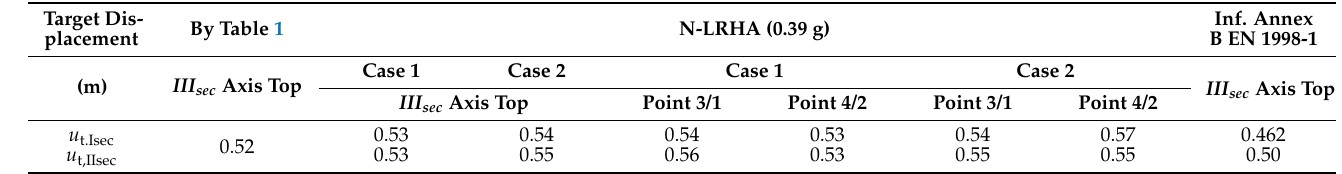
Table 3. Comparison of target displacement at the top of the